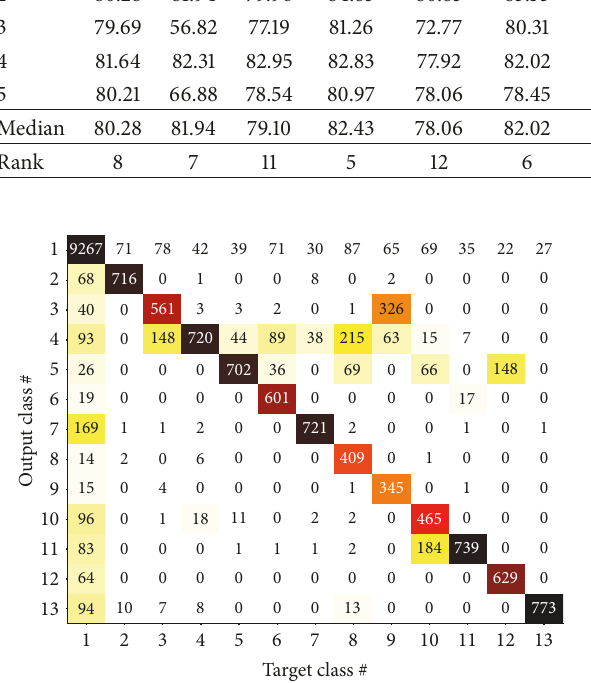
Figure 8: Confusion matrix, HSMM, MAV, Subject 4. There are around 800 observations per movement and 10100 in the rest